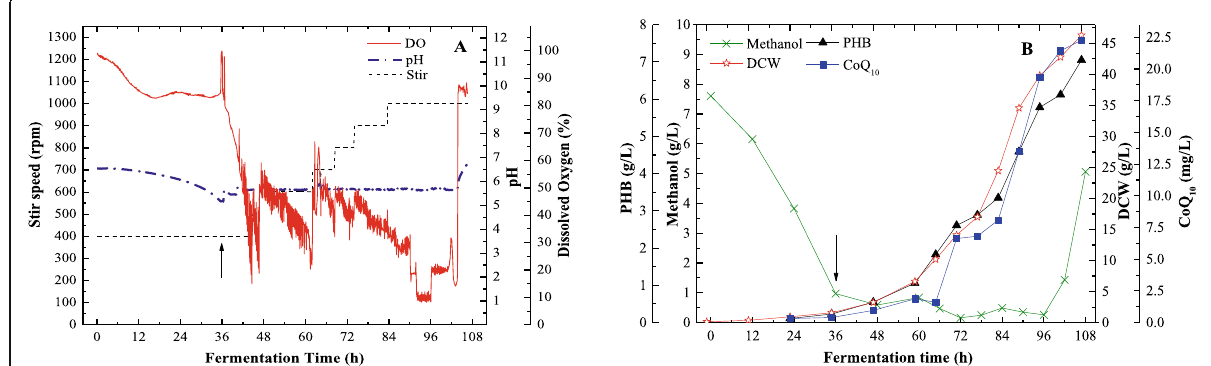
Fig. 7 Online parameter acquisition curve ( a ) and CoQ 10 and PHB fermentation of XJLW via fed-batch process ( b ) in a 5-L stirred tank reactor. The arrow demarcates the feeding